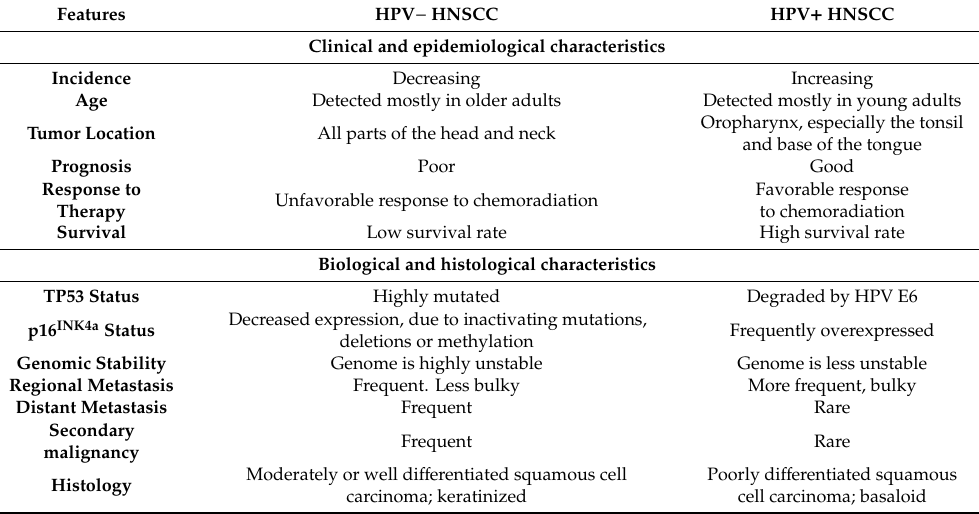
Table 1. Overview of the key di ff erences between HPV − and HPV +